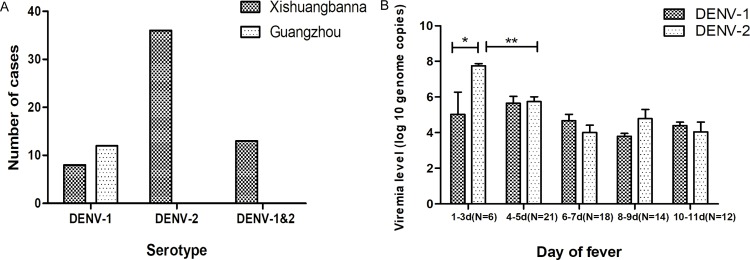
Serotyping and quantitating of DENV in the two study areas.(A) A comparison of the serotypes by RT-qPCR in the two study regions and (B) titering according to the onset day of fever in patients from which DENV RNA was isolated.